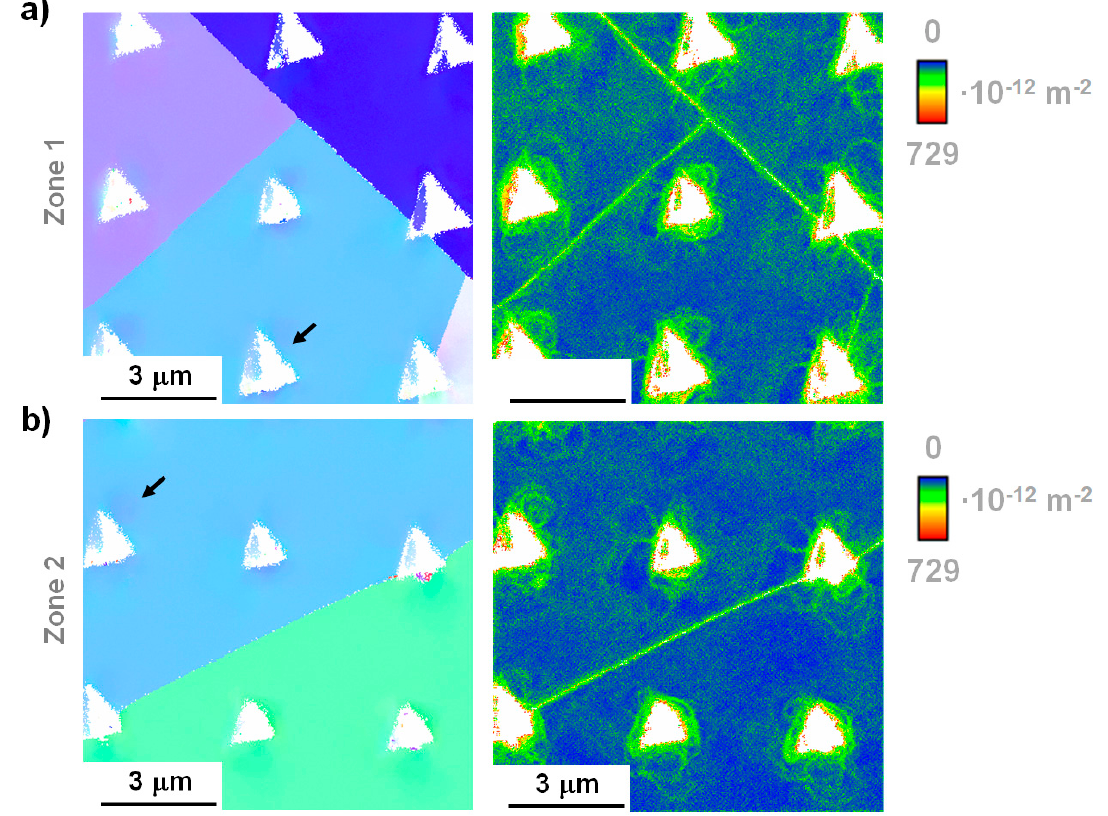
Figure 3. The local crystallographic orientation (left hand side) and the geometrically necessary dislocations (GNDs) map (right hand side), for both regions of interest labelled in Figure 1a, observed in more detail (( a ) and ( b ), respectively).